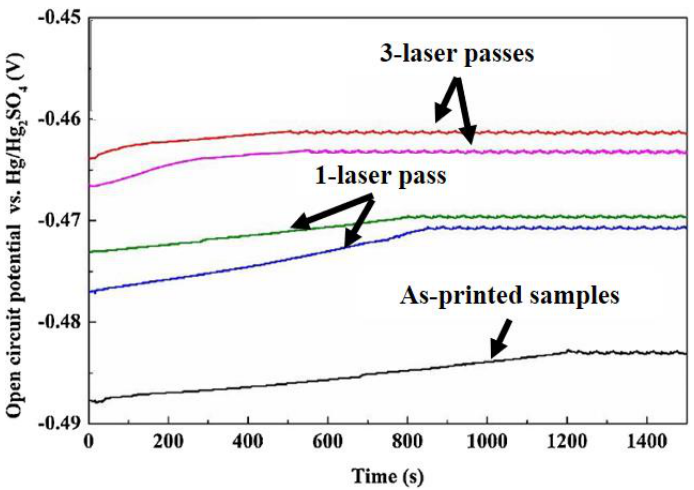
Figure 19. Corrosion test for as-printed and LP AISI 316 L samples [91]; with permission from Else- vier.